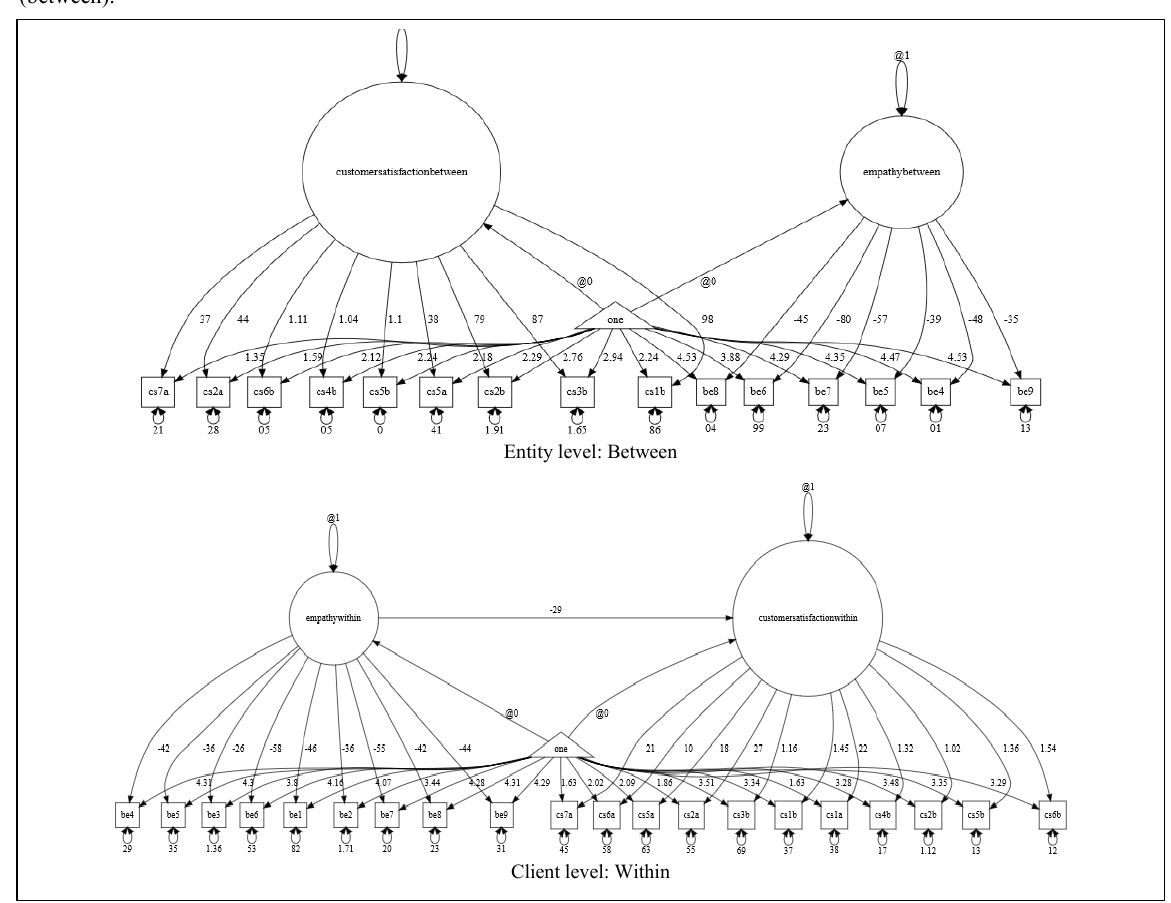
Figure 2: Path diagram showing the effect of Empathy on customer satisfaction From the measurement model of empathy, factor scores were generated and used as latent variables to assess the influence of empathy on customer satisfaction using the REML mixed effect models. According to the analysis in table 6, empathy has a significant coefficient estimate ( β =0.179, Z= 4.340, p-value = 0.000) as a level 1 variable in the fixed effect components. The random